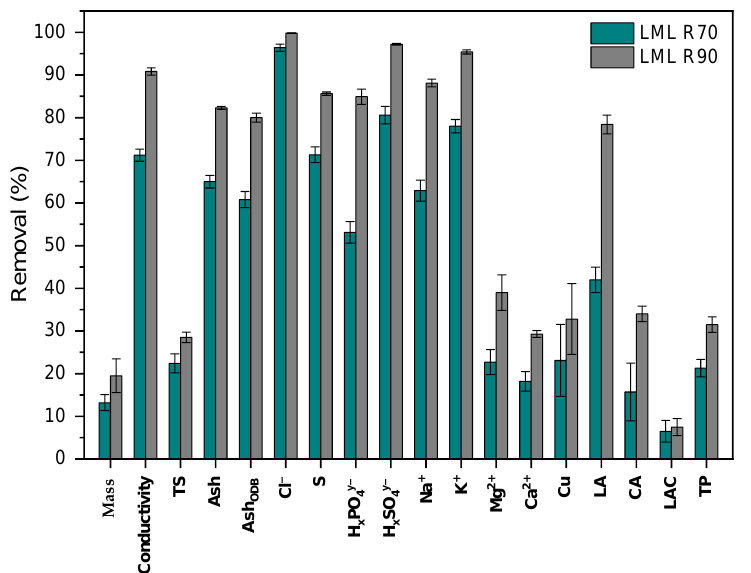
Figure 4. The removal of the absolute content of the components of final products LML R70 and LML R90. LML